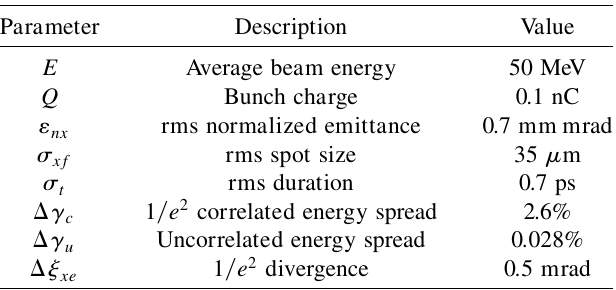
TABLE I. Summary of the simulated electron beam parame- ters at the